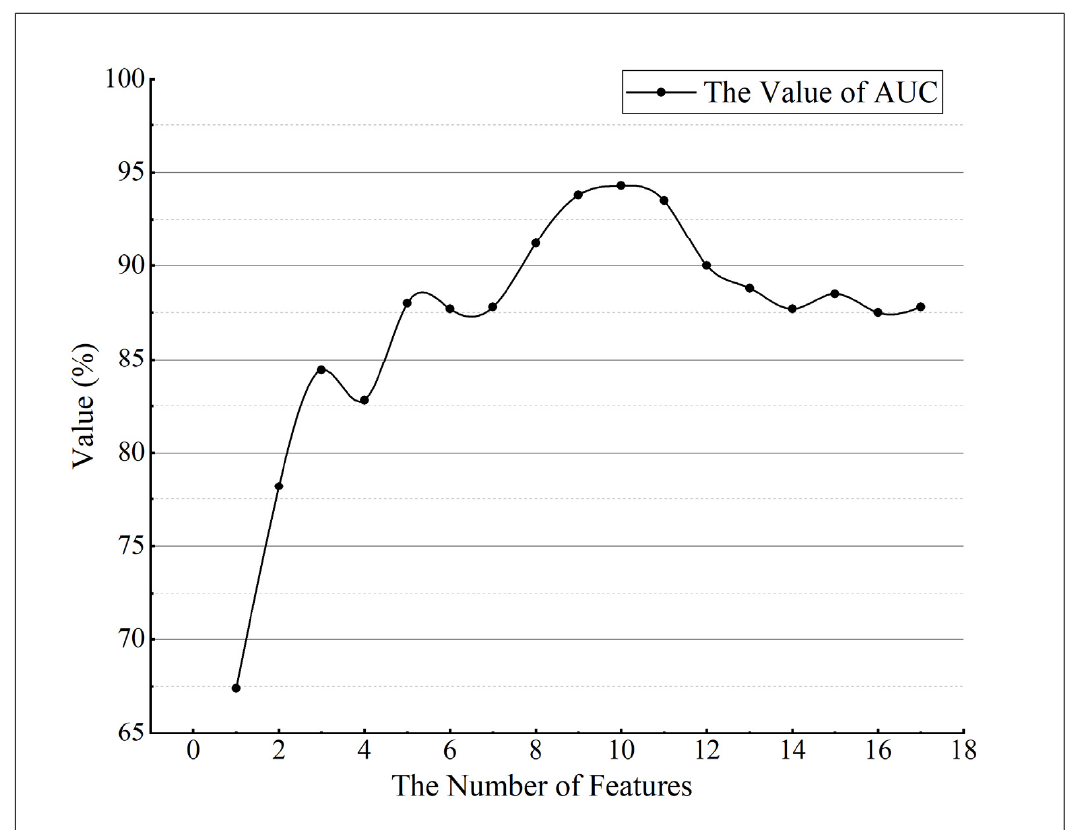
Figure 6. RF feature importance score result.